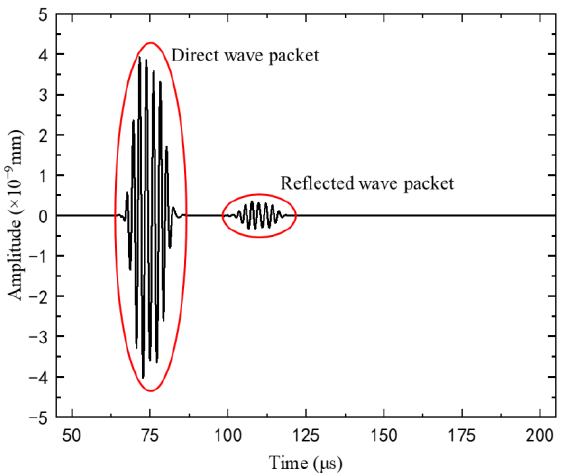
Figure 33. The direct wave packet and the reflected wave packet.